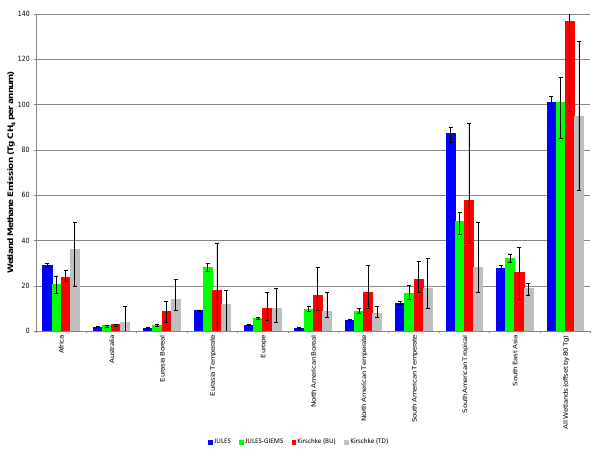
Figure 12. Mean annual methane emissions for the period 2000– 2009 from the JULES (blue) and JULES-GIEMS (red) used in this work and the bottom–up (green) and top–down (grey) estimates of Kirschke et al. (2013). The “all wetlands” components have been offset by 80TgCH 4 yr − 1 for greater clarity. The error bars give the range of